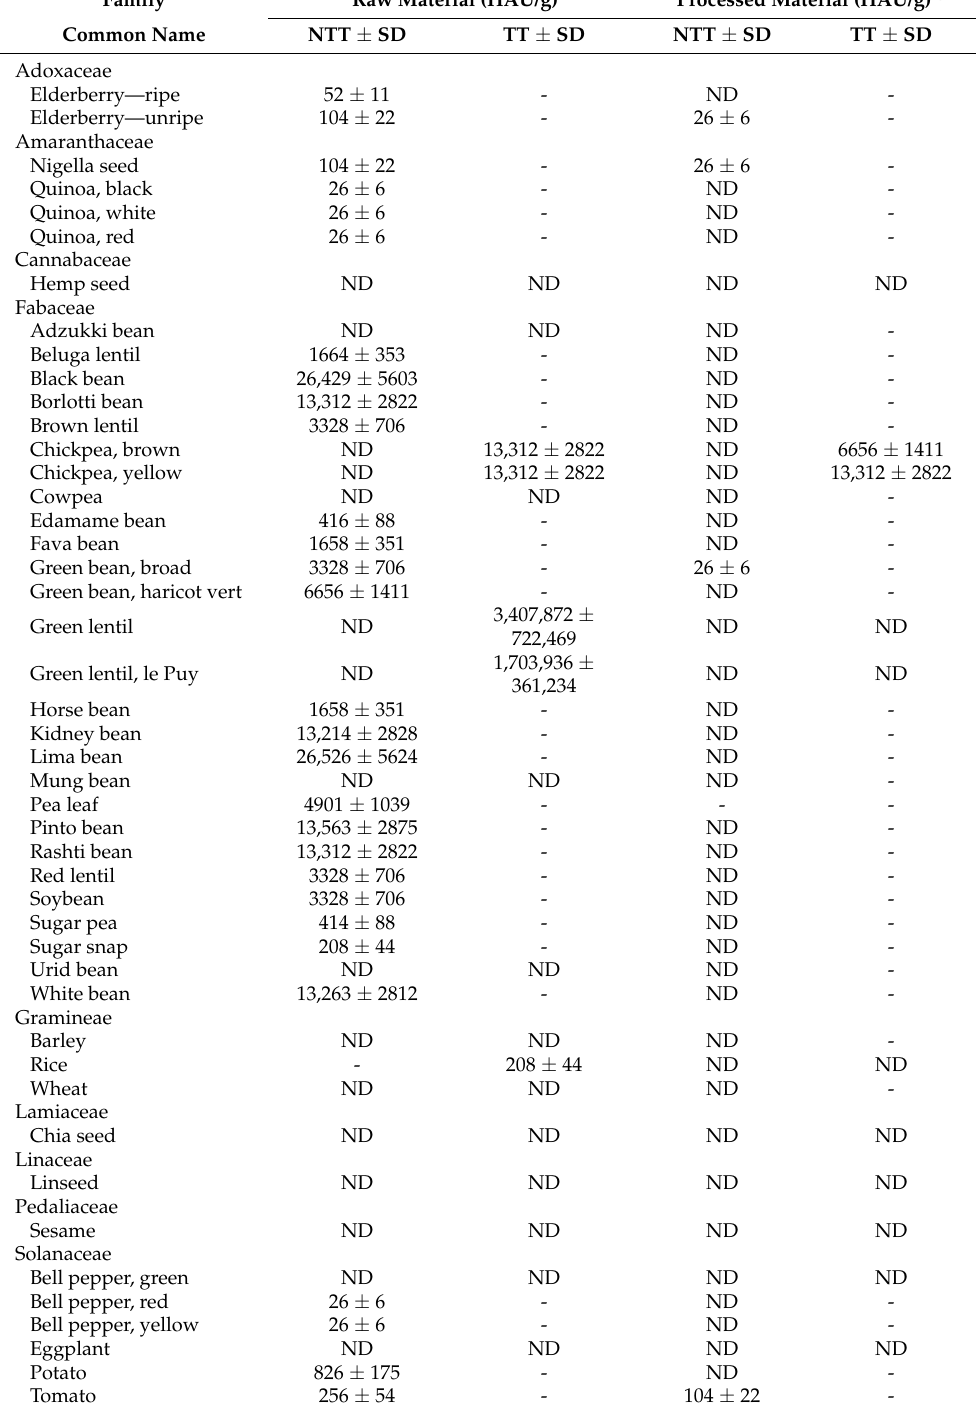
Table 3. Lectin activity (HAU/g) results obtained with the non-trypsin treated and trypsin treated hemagglutination assay using rabbit erythrocytes in raw and processed